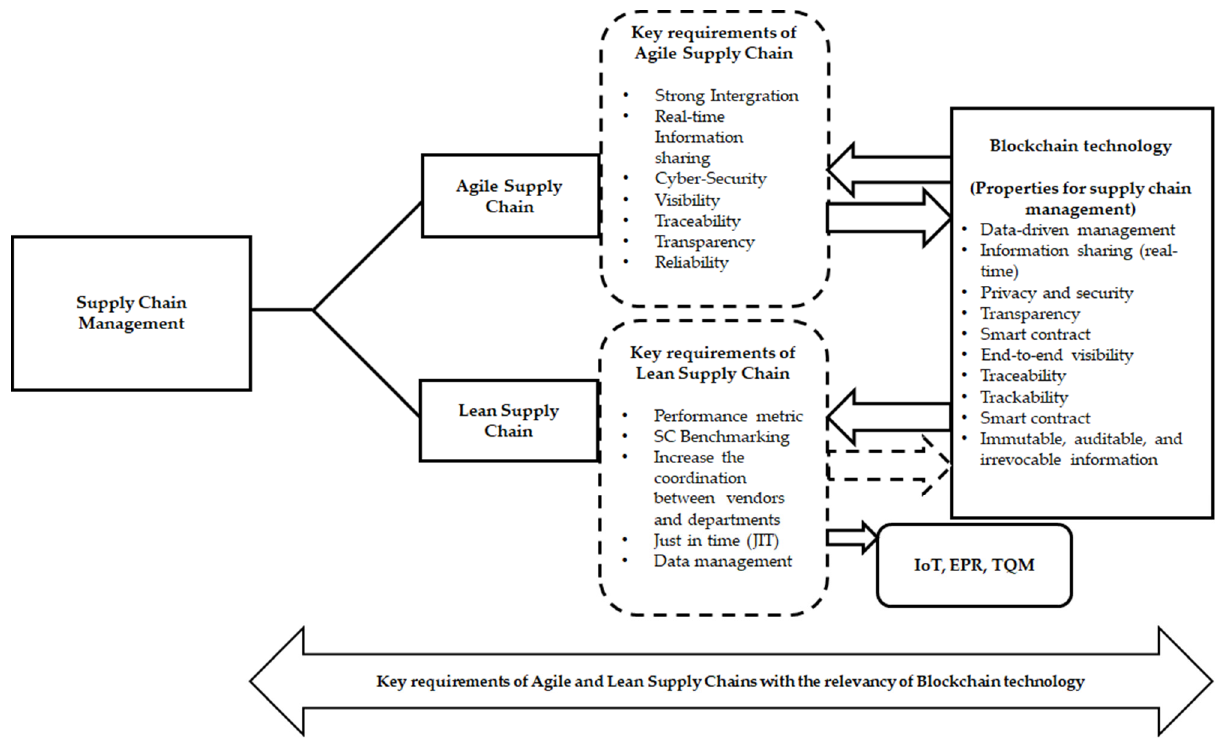
Figure 3. Implication of blockchain for agile and lean supply chains.